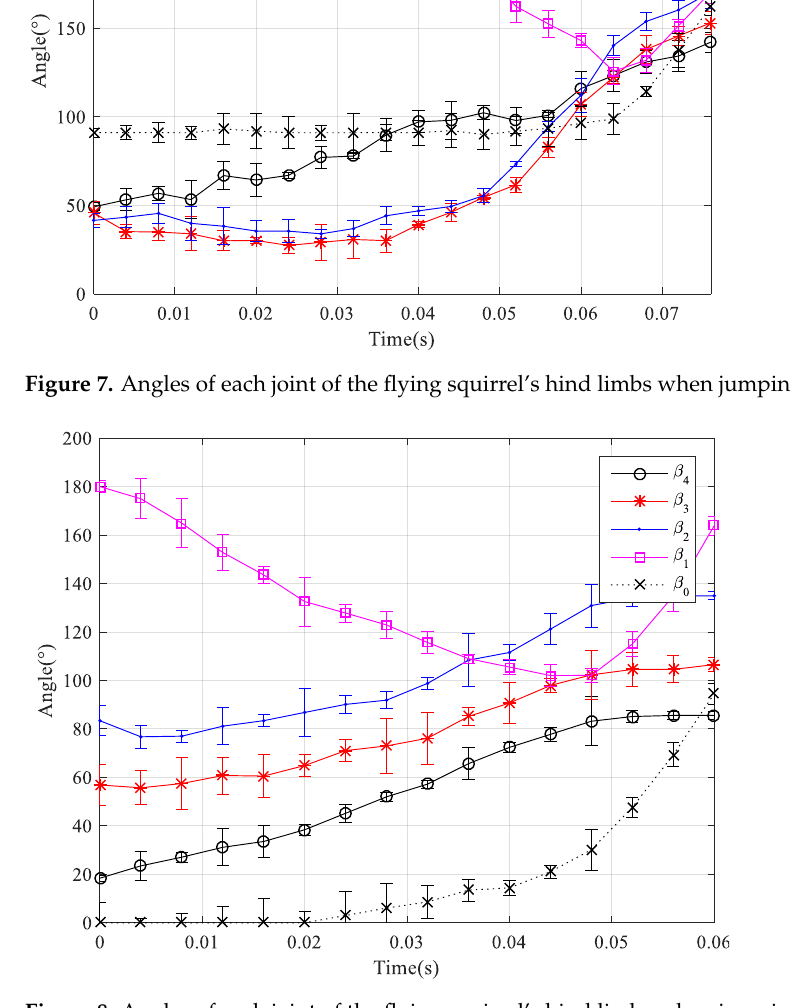
0 x and , respectively. Ignoring the